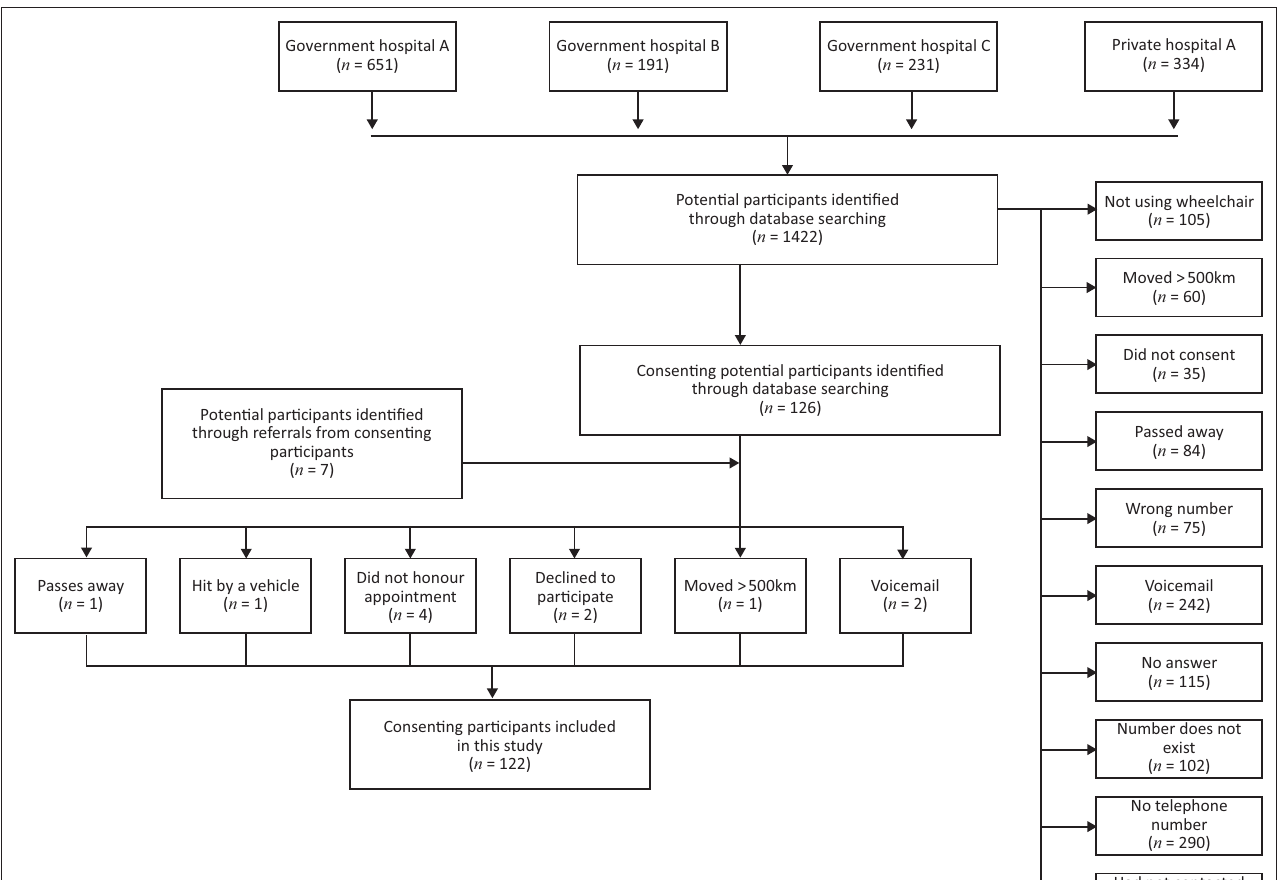
FIGURE 1: Flow diagram of the included participants in this